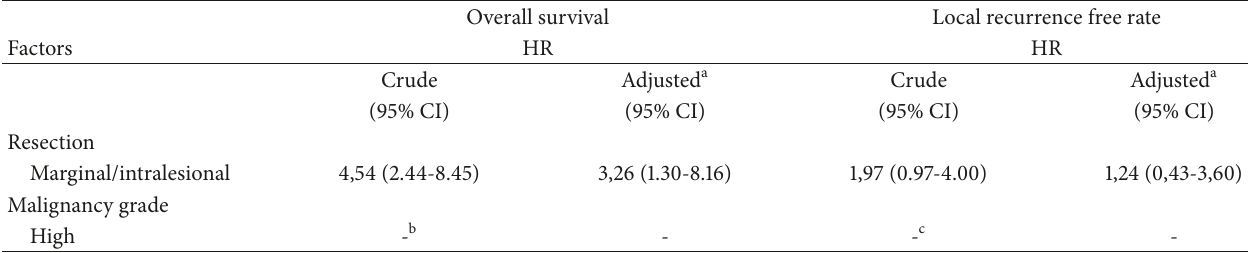
Table 3: Analyses of unfavorable prognostic factors for survival and local control.